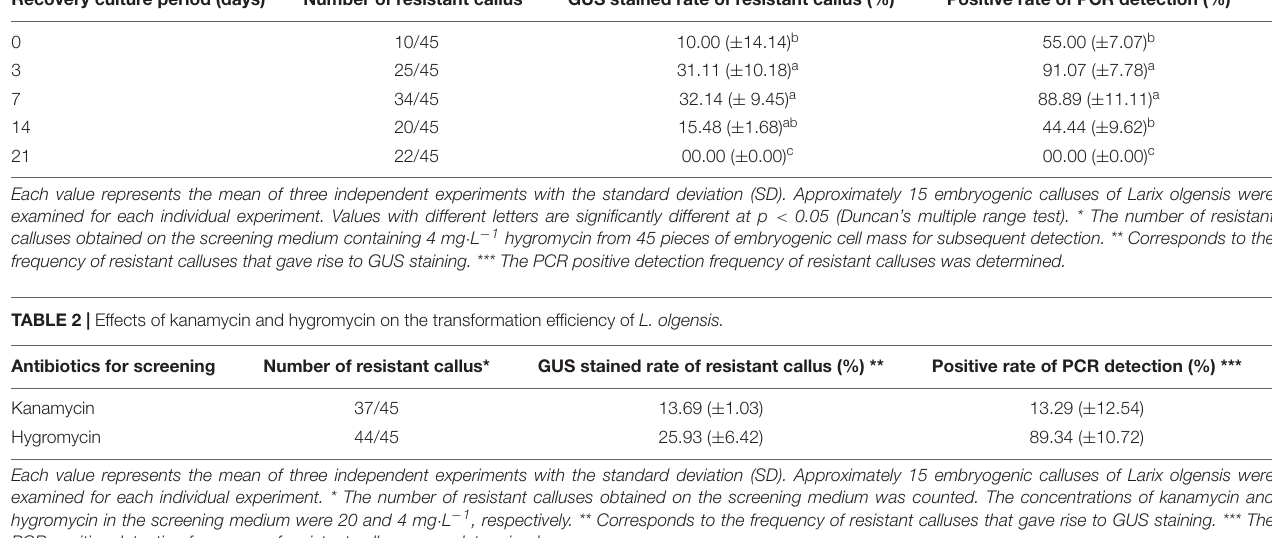
TABLE 1 | Effects of the duration of recovery post-bacteriostasis on the transformation efficiency of L. olgensis . Recovery culture period (days)